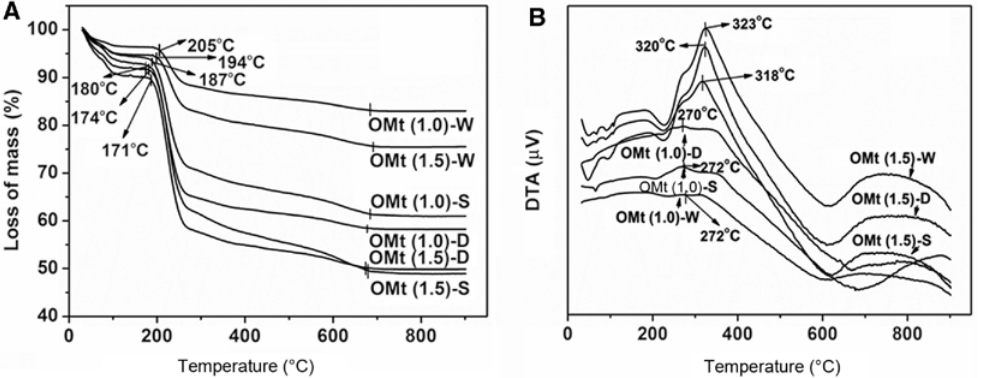
Figure 3: TG and DTA diagrams of OMts. (A) TG diagram of OMI (B) DT diagram of OMI. OMt (1.0)-W: montmorillonite modified by wet method with 1.0 CEC of cationic surfactants. OMt (1.0)-S: montmorillonite modified by semi-dry method with 1.0 CEC of cationic surfactants. OMt (1.0)-D: montmorillonite modified by dry method with 1.0 CEC of cationic surfactants. OMt (1.5)-W: montmorillonite modified by wet method with 1.5 CEC of cationic surfactants. OMt (1.5)-S: montmorillonite modified by semi-dry method with 1.5 CEC of cationic surfactants. OMt (1.5)-D: montmorillonite modified by dry method with 1.5 CEC of cationic surfactants.